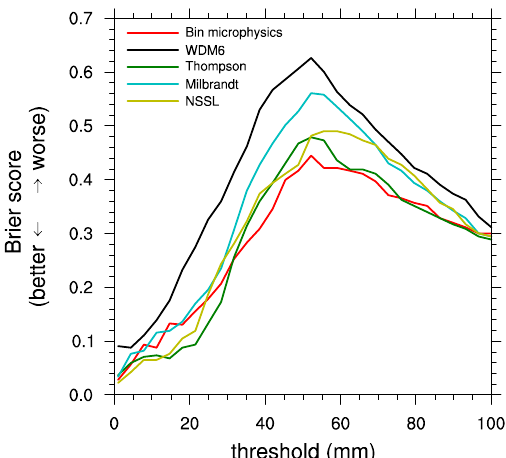
Figure 4. The Brier score for the 18-hr accumulated surface precipitation amount of each microphysics scheme across a range of thresholds. A lower Brier score indicates better model performance, and a higher Brier score worse model performance.